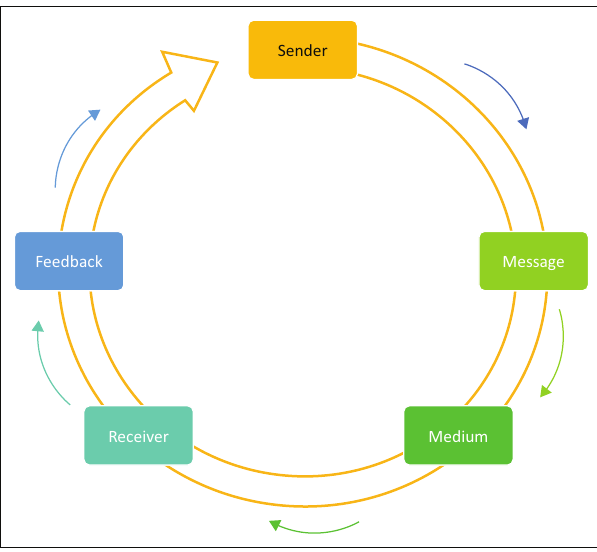
FIGURE 1: The flowchart diagram of